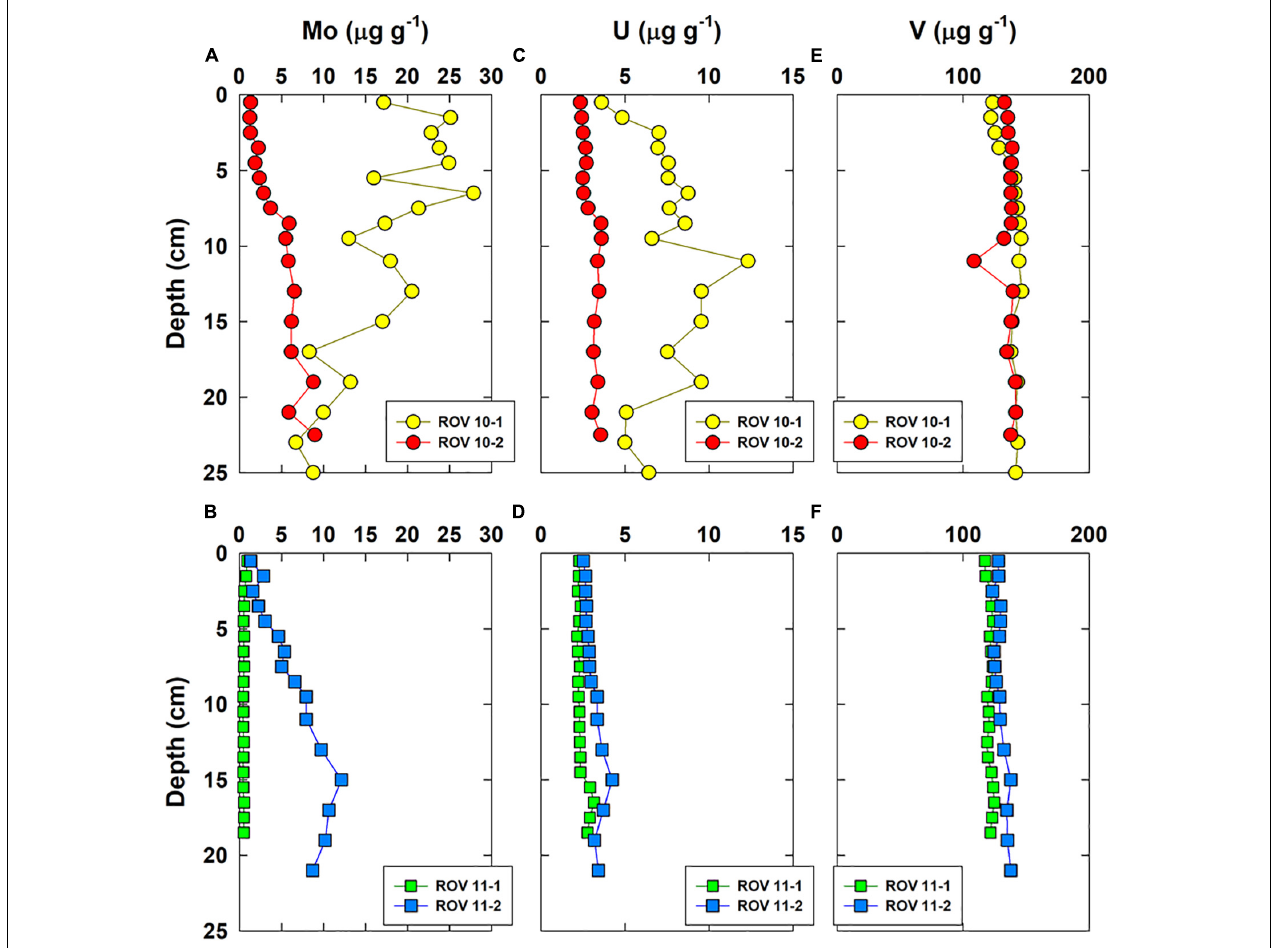
FIGURE 4 | Vertical concentration profiles of Mo (A,B) , U (C,D) , and V (E,F) in bulk sediments of the four cores collected from the southern Okinawa Trough.